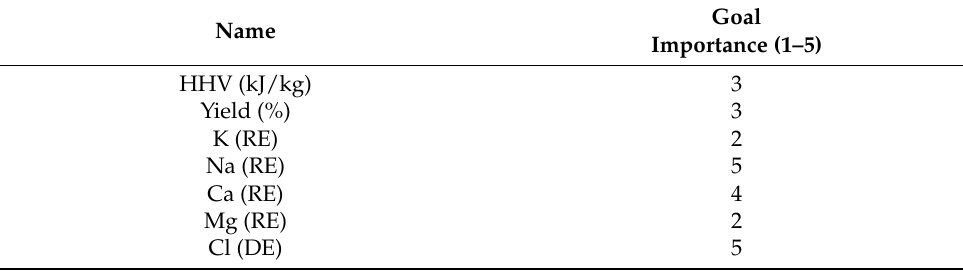
Table 2. Evaluation of the importance of target variables.